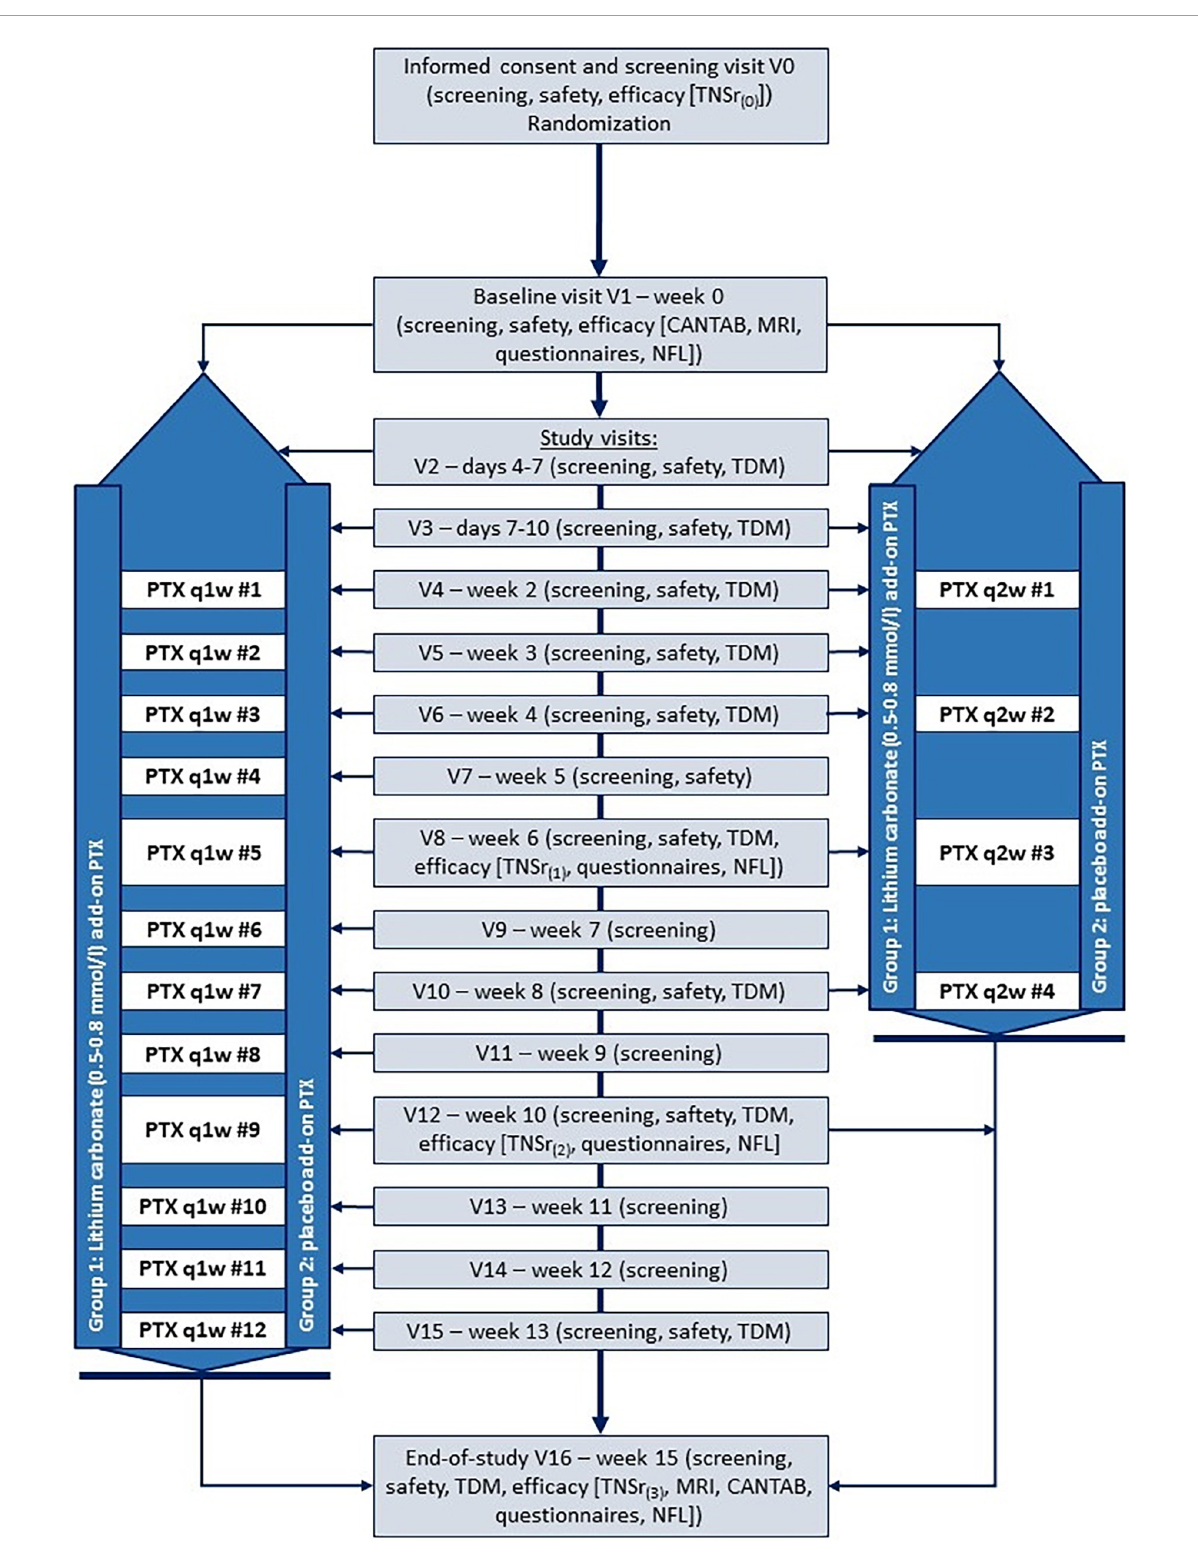
FIGURE2 Scheme of intervention in PREPARE trial. CANTAB, Cambridge Neuropsychological Test Automated Battery; MRI, magnetic resonance imaging; NFL, neurofilament light chain protein; PTX, paclitaxel; TDM, therapeutic drug monitoring; TNSr, total neuropathy score